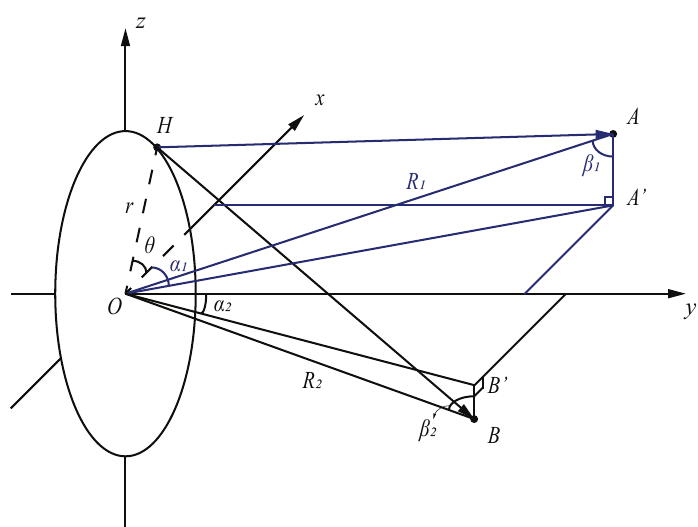
Figure 2. Geometry of monostatic radar remote sensing targets (the positive y axis is the boresight direction).